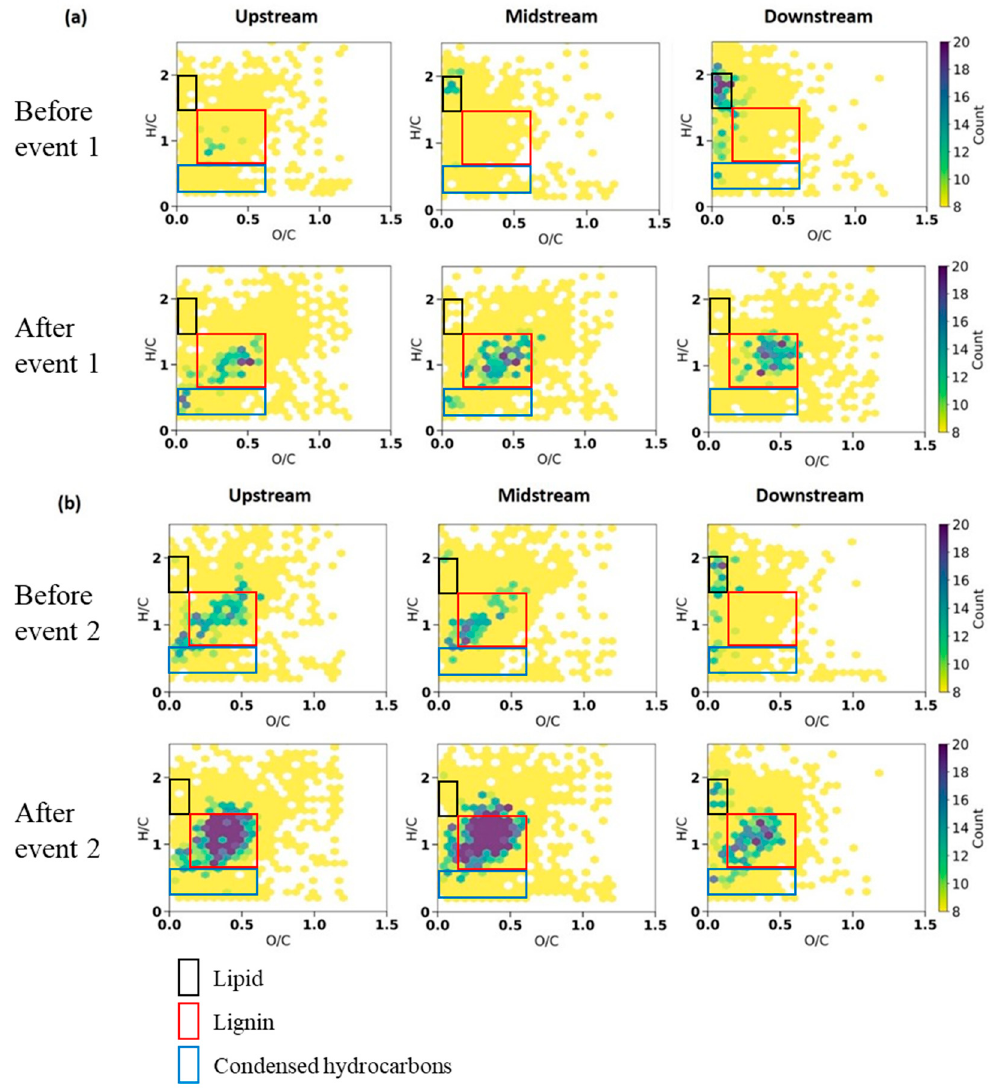
Figure 9. Van Krevelen diagrams of CHON formulae of DOMs at each sampling point in ( a ) Event 1 and ( b ) Event 2 .